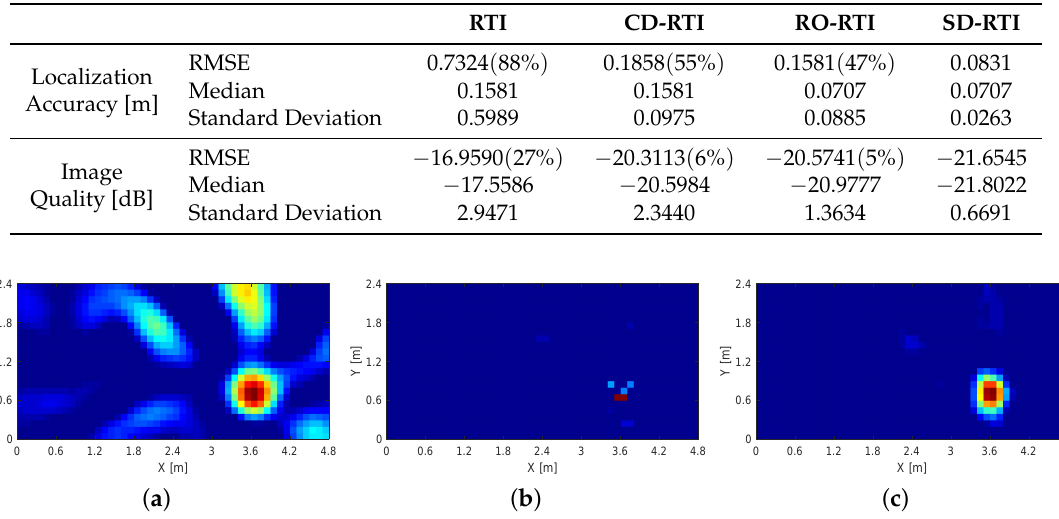
Figure 5. The attenuation image reconstructed using ( a ) Tikhonov ( (cid:96) 2 -norm); ( b ) LASSO ( (cid:96) 1 -norm); and ( c ) proposed ( (cid:96) 1 + (cid:96) 2 ). The image quality of the proposed method is more clear and accurate than the other two